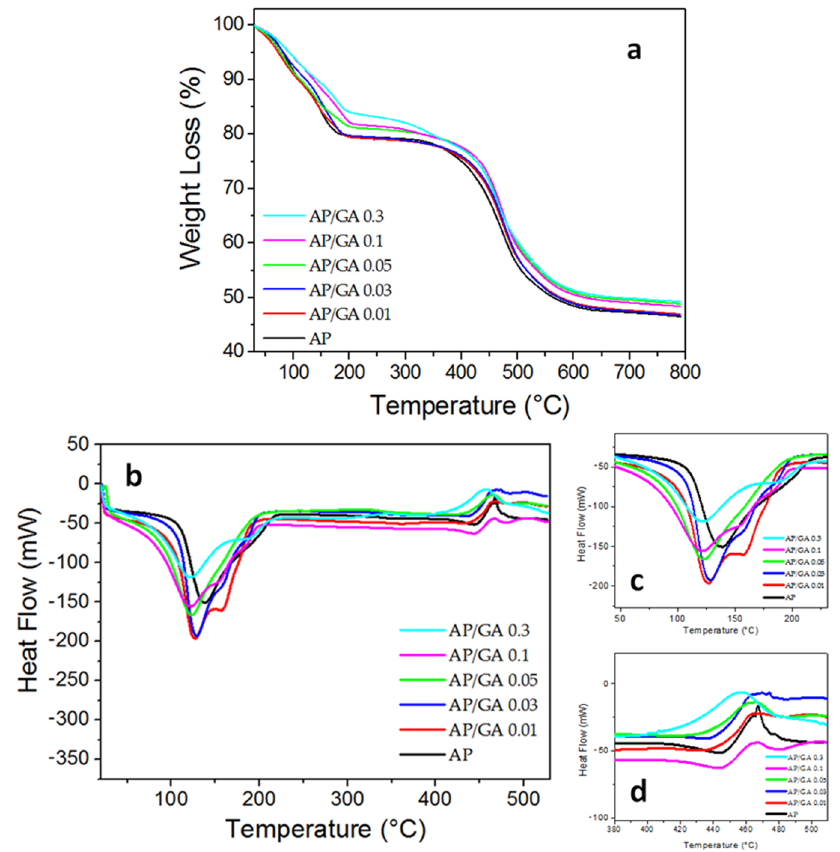
Figure 3. TG ( a ) thermograms and DSC ( b – d ) curves for AP, GA and AP/GA coatings. All experi- ments were performed under inert atmosphere.